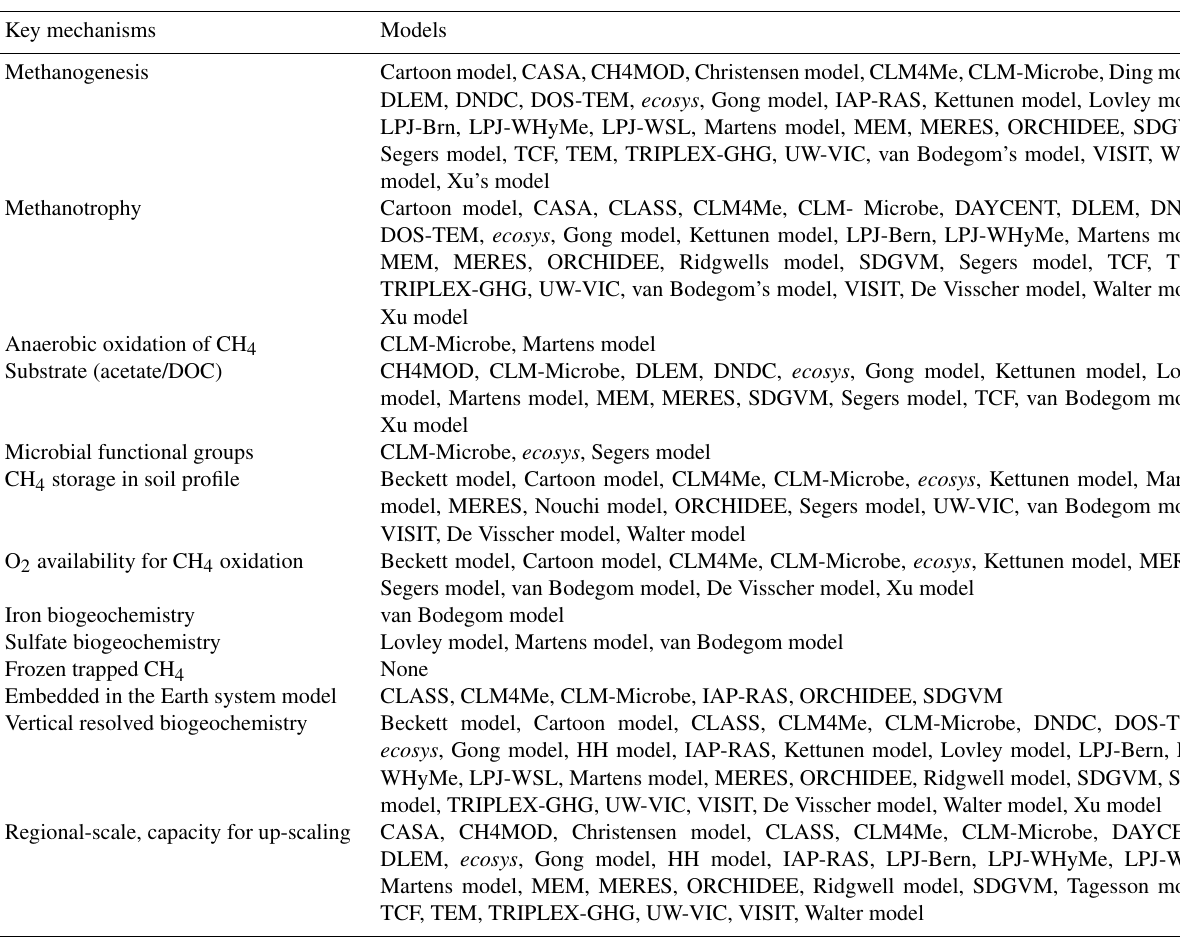
Table 2. Key mechanisms/features of CH 4 processes and their representations in CH 4 models. Key